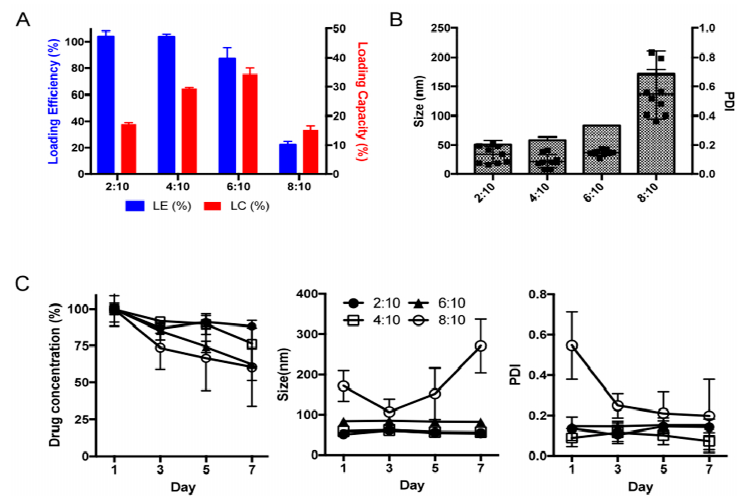
Figure 2. UCH-L1 inhibitor LDN-57444 can be e ff ectively loaded into polymeric micellar system based on amphiphilic polyoxazoline block copolymer. ( A ) Loading e ffi ciency (LE) and loading capacity (LC) of LDN-POx micelles at LDN:POx w / w ratios of 2:10, 4:10, 6:10 and 8:10. LE of LDN-POx micelles remained close to 100% up to 6:10 LDN:POx ratio, resulting in LC of 35% w / w . ( B ) Particles size and particles size distribution of LDN-POx micelles at LDN:POx w / w ratios of 2:10, 4:10, 6:10 and 8:10. LDN-POx micelles formed small (50–70 nm), homogenous particles (polydispersity index (PDI) approx. 0.2) up to 6:10 LDN:POx ratio. ( C ) Stability of LDN-POx micelles stored at 4 ◦ C overtime as